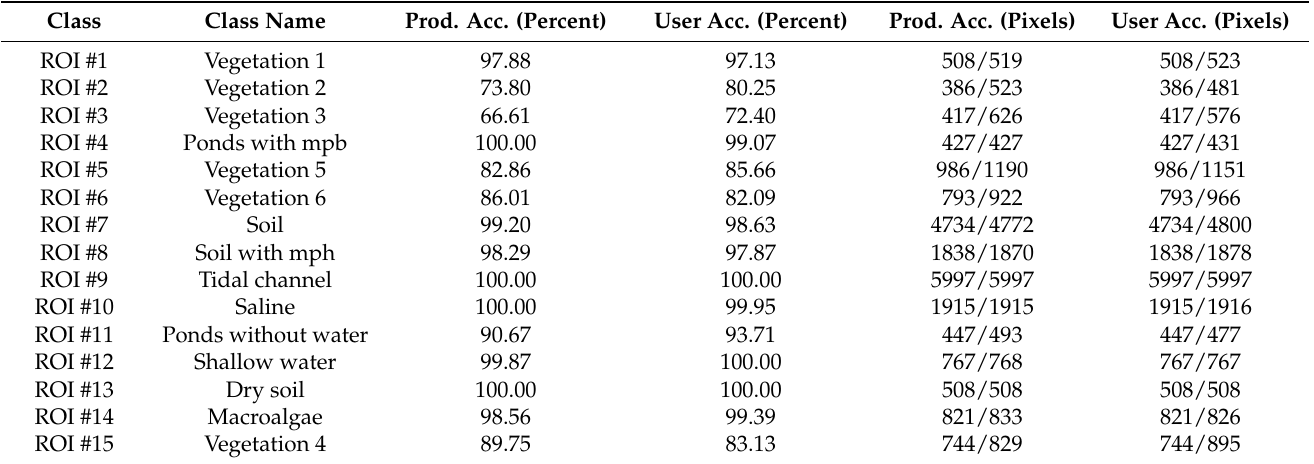
Table A3. Report for the accuracy of the comparison of classification results to random samples generated from ROIs. The table summarizes the producer accuracy and user accuracy in percentage and pixels for each class.